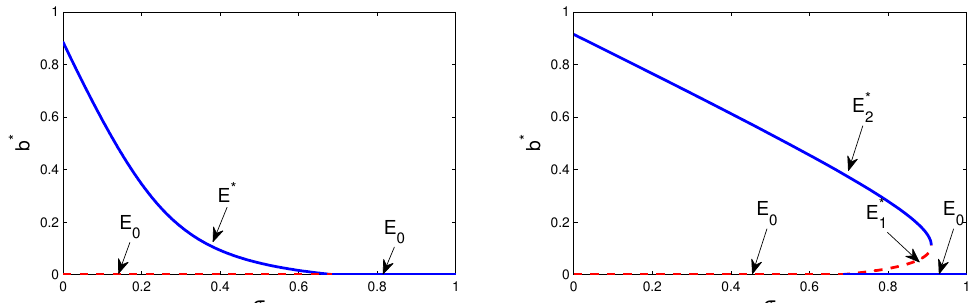
Figure 1. Bifurcation diagram in the plane ( σ , b ∗ ). The other parameters are µ = 0.05; ρ = 0.25; λ = 0.02; p = 0.7; q = 0.8; a = 0.5; k = 2; γ = 0.2 so that α ∗ = 1.1684 and σ c = 0.6850. The solid lines (-) denote stability; the dashed lines (- -) denote instability. ( Left ) Forward scenario. The case α < α ∗ , α = 0.4 − At σ = σ c = 0.6850, system (5) exhibits a forward bifurcation. ( Right ) Backward scenario. The case α > α ∗ , α = 2 − At σ = σ c = 0.6850, system (5) exhibits a backward bifurcation. The value σ SN = 0.9105 is the saddle-node bifurcation